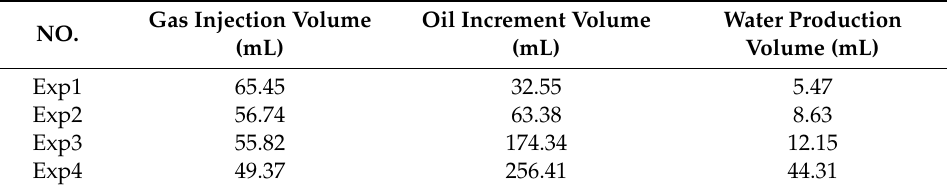
Table 6. Production dynamic data summary of di ff erent experiments.